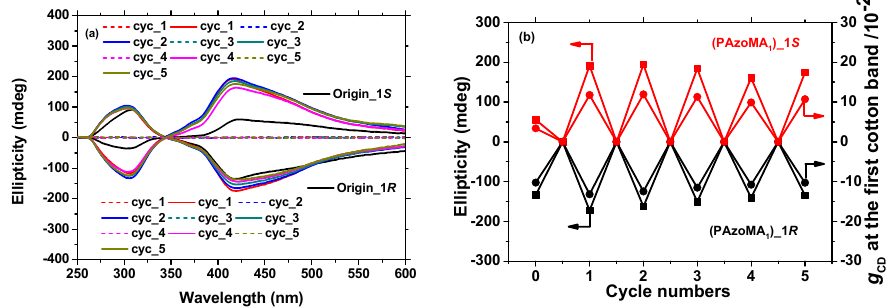
Figure 3. Changes in CD spectra ( a ) and the maximum CD and g CD values ( b ) of PAzoMA 1 films during heating to 70 °C and cooling to 60 °C five times.